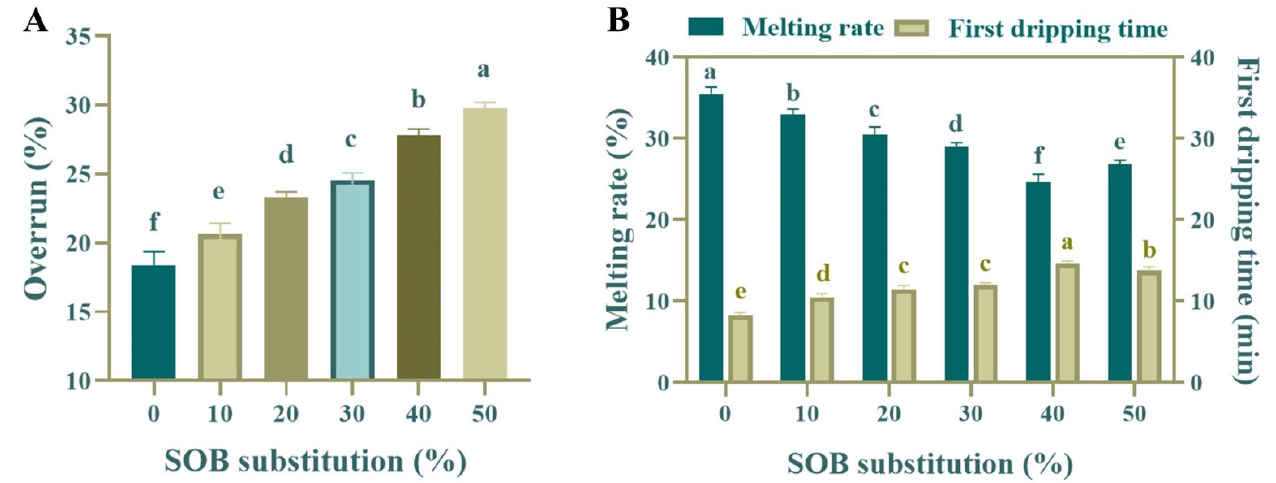
Figure 2. Effects of different SOB substitution amounts on ( A ) overrun and ( B ) melting properties of ice cream. Different alphabet represents significant difference in the same indicator ( p < 0.05).